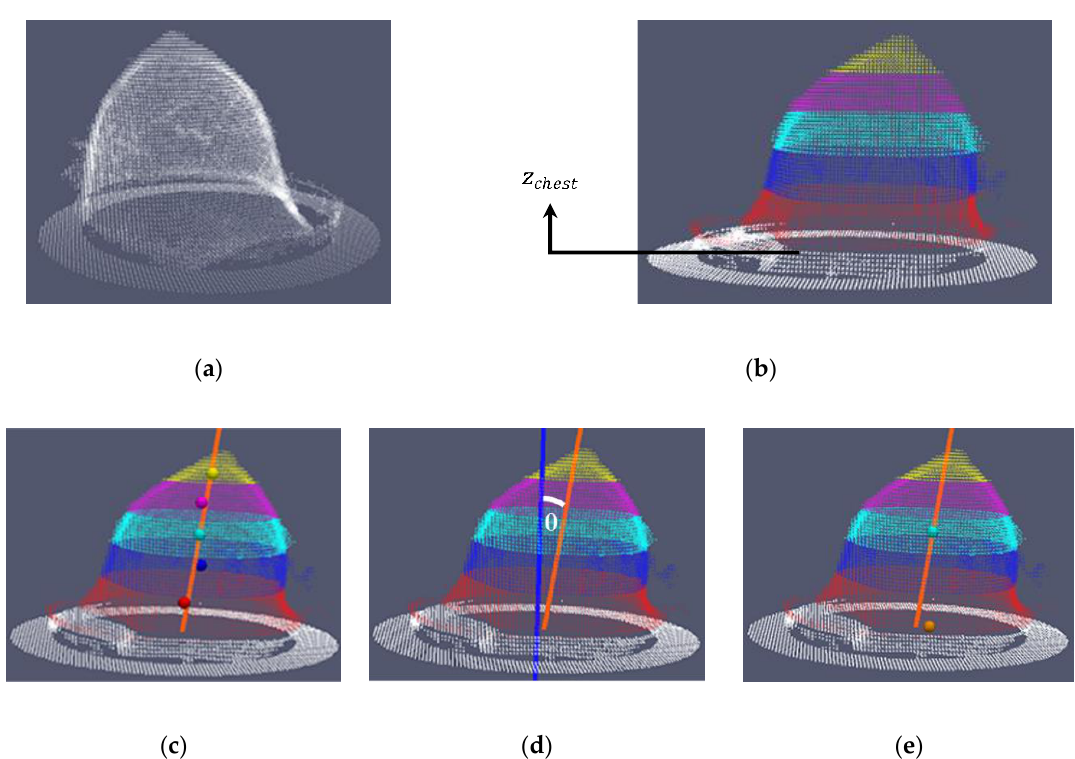
Figure 14. ( a ) Voxelized point cloud; ( b ) The five vertical sections of the breast, highlighted with different colors; ( c ) Orientation axis of the breast and centroids (colored spheres) of the pre-defined vertical sections; ( d ) The angle θ between the orientation axis of the breast (orange color) and the z axis of the Wavelia reference coordinate system (blue color); ( e ) New origin point p str (orange sphere).